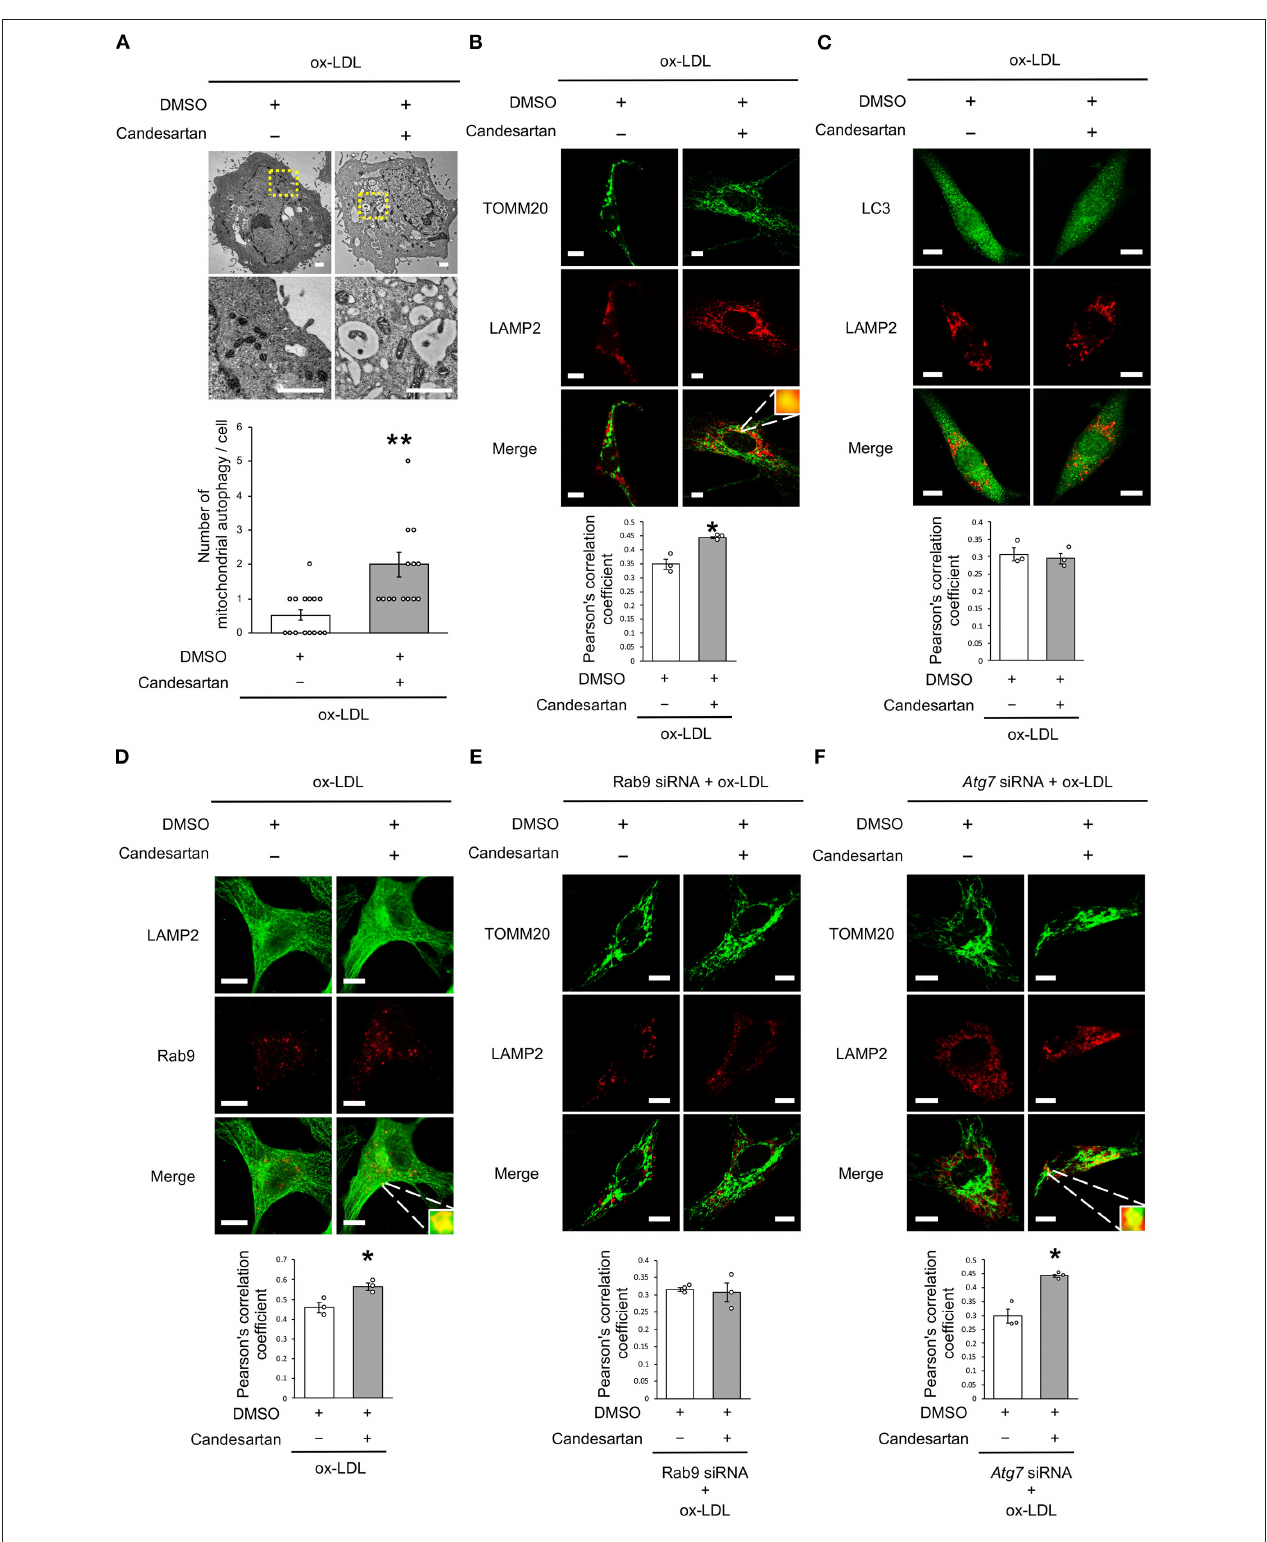
FIGURE 5 | AT1R inhibition induced mitochondrial autophagy derived from Rab9-dependent alternative autophagy with ox-LDL treatment. (A) Electron microscopic images and quantitative analysis of the number of mitochondrial autophagy in Candesartan-treated vs. the control cells with ox-LDL. Scale bar = 1 µ m. ** P < 0.01